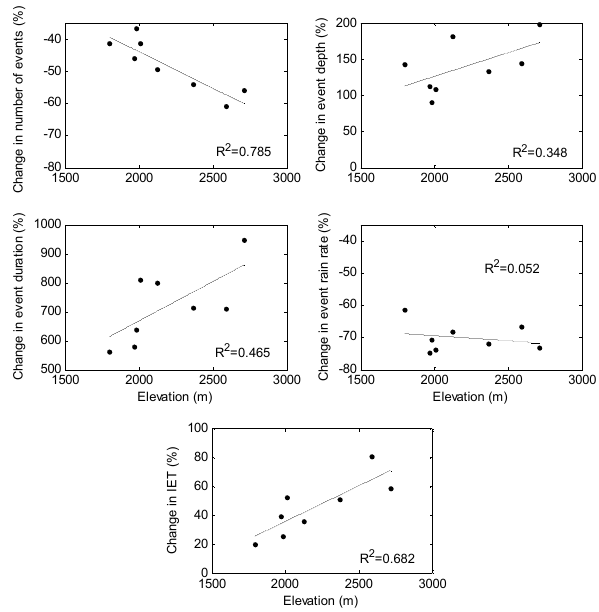
Fig. 7 Percent changes in the event properties by changing the minimum inter-event 765 Fig. 7. Percent changes in the event properties by changing the time (MIT) from 30 minutes to 8 hours. Results are plotted against the terrain 766 minimum inter-event time (MIT) from 30min to 8h. Results are elevation of all eight gauge stations. 767 768 plotted against the terrain elevation of all eight gauge stations.